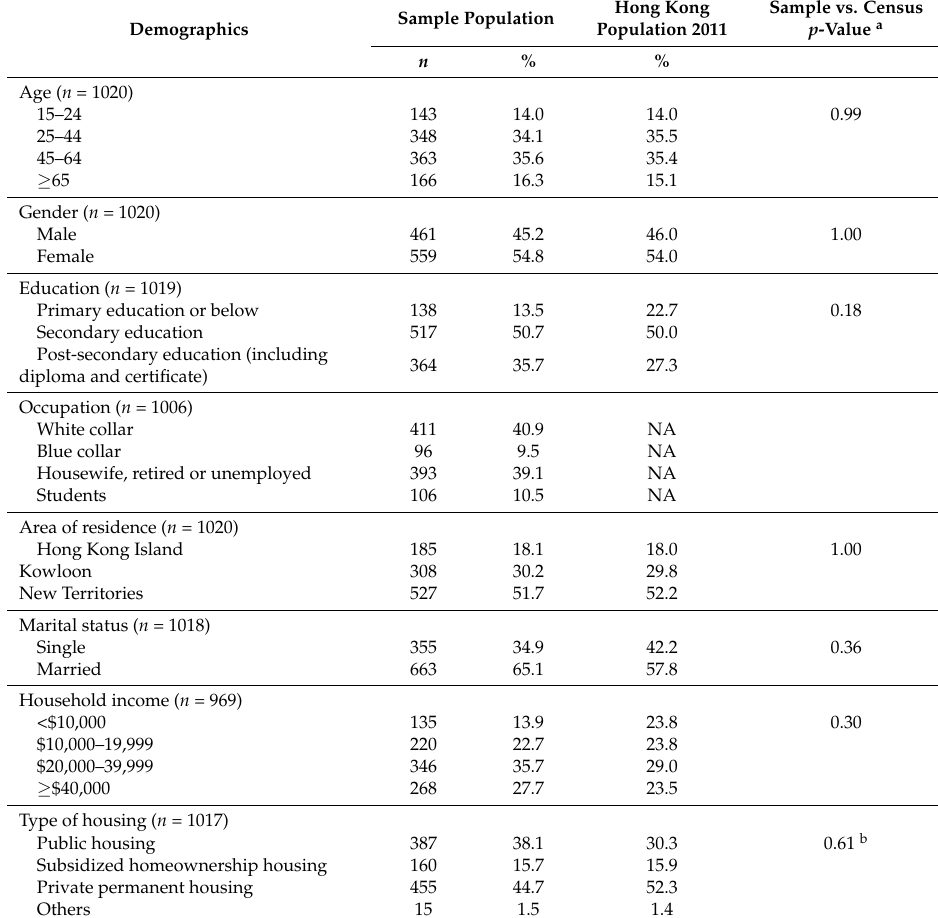
Table 1. Socio-demographic characteristics of respondents and the general population in Hong Kong 2011. Demographics